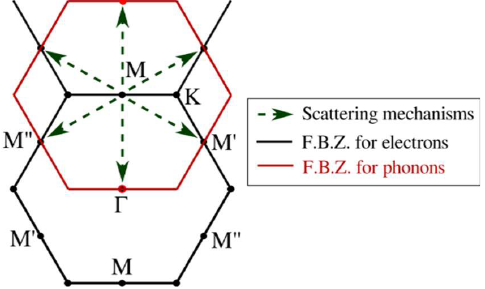
Figure 4. Electron–phonon interaction matrix elements in units of eV for initial k of the conduction band minimum (M valley) for different phonon branches. It can be observed that the dominant scattering mechanisms are the intra-valley and inter-valley (M → M’, M”) mechanisms. Other elements representing M → Γ scattering and also scattering to higher energy states will become significant for higher electric fields.